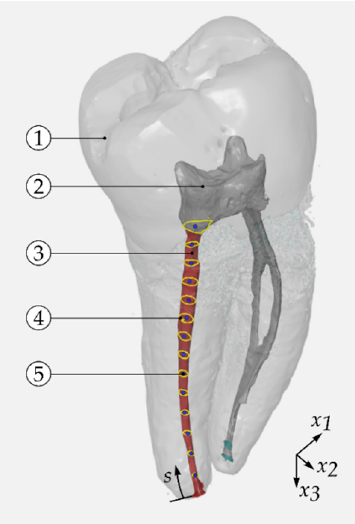
Figure 2. Exemplarily determination of centroids (reduced number slices per long axis of tooth): outer contour of first molar, 1 ; root canal morphology, 2 ; distal root canal (region of interest (ROI), red surface), 3 ; root canal’s cross-section slice (yellow lines), 4 ; centroid (blue points), 5 .